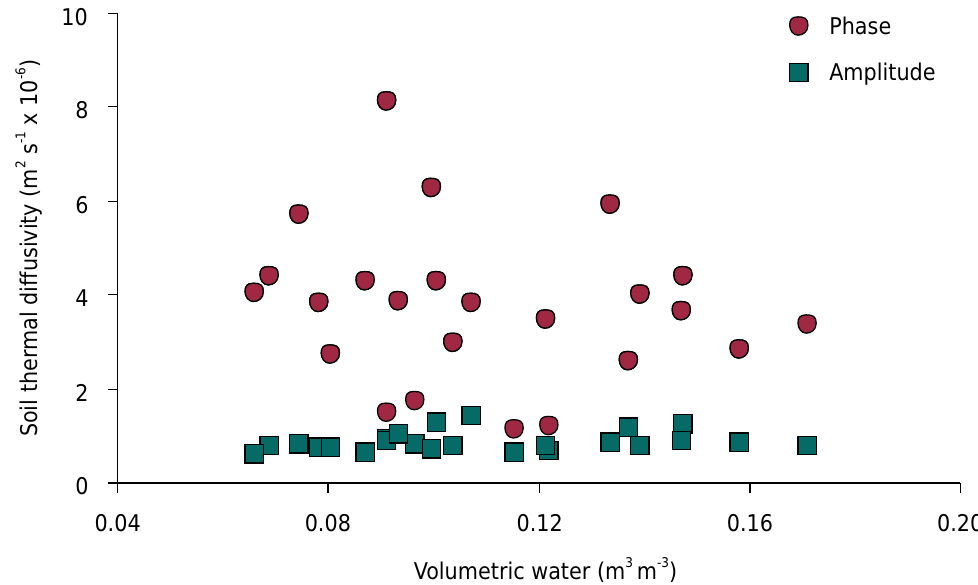
Figure 7. Soil thermal diffusivity at the 0.05 and 0.20 m depths depending on the soil moisture variation, estimated from soil temperature data recorded in a Cambissolo Háplico Ta Eutrófico (Cambisol; Inceptisol) from February 04, 2014, to September 30, 2015, in São Gabriel, Irecê Identity Territory, Bahia,